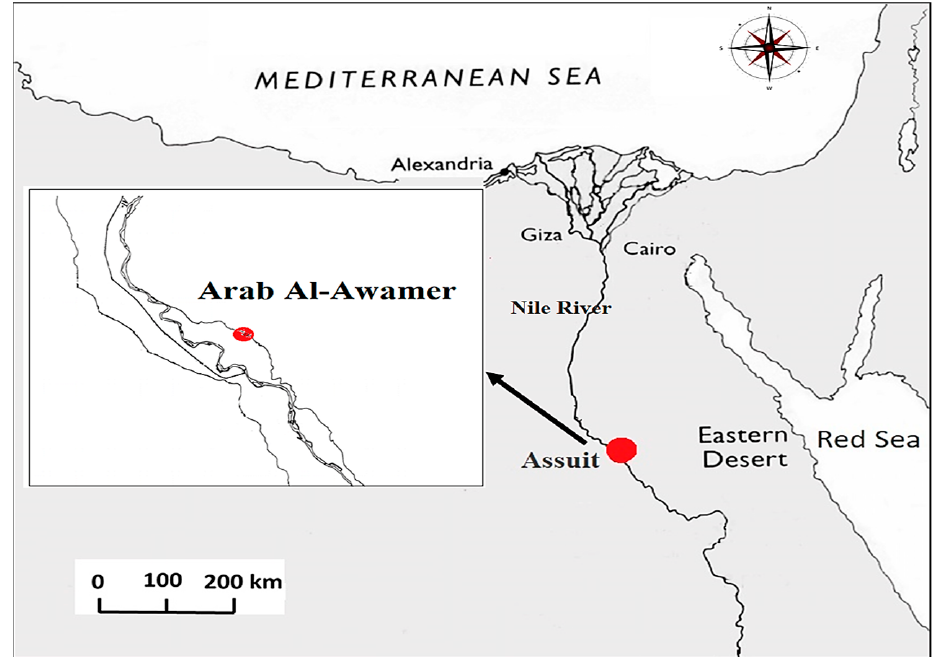
Figure 1. A map illustrating the experimental site of Arab El-Awammer. Research Station, Agri- culture Research Institute (ARC), Assuit, Egypt.